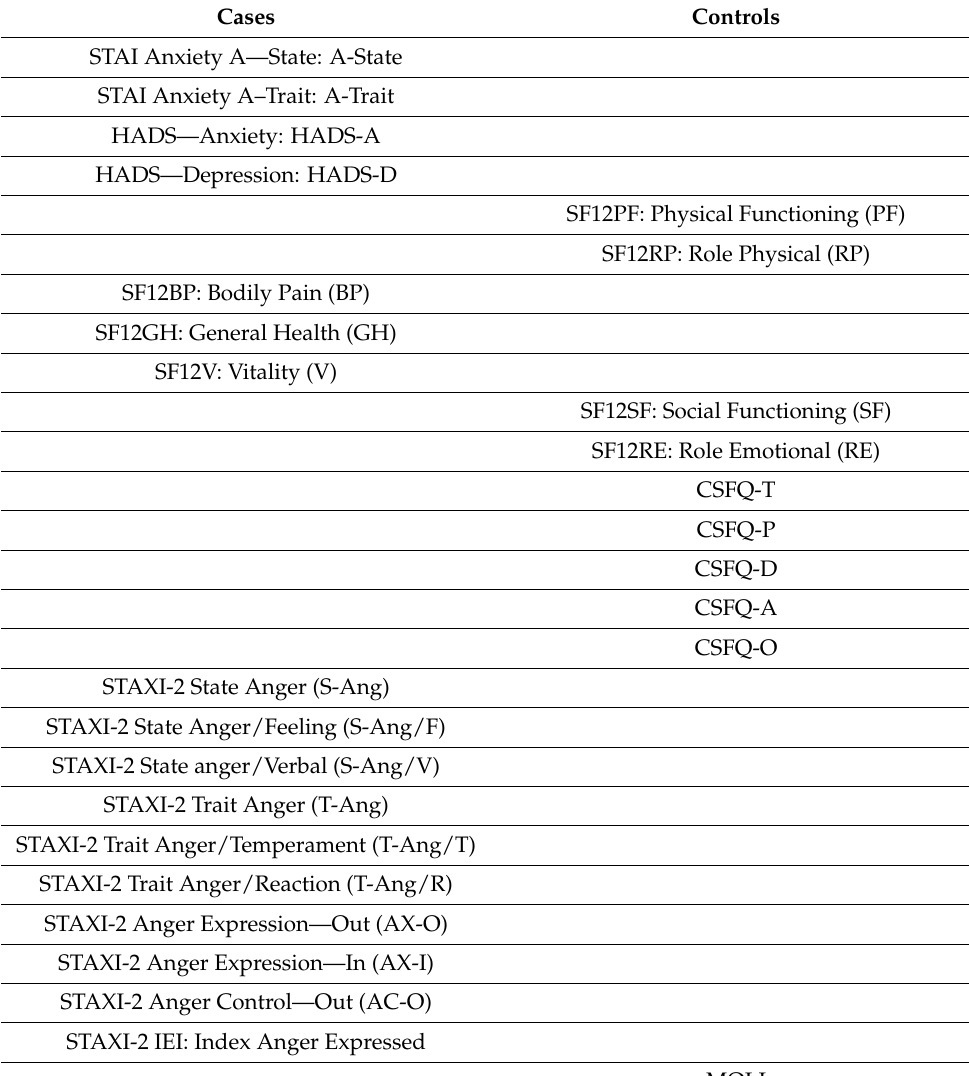
Table A3. Significant associated factor with each